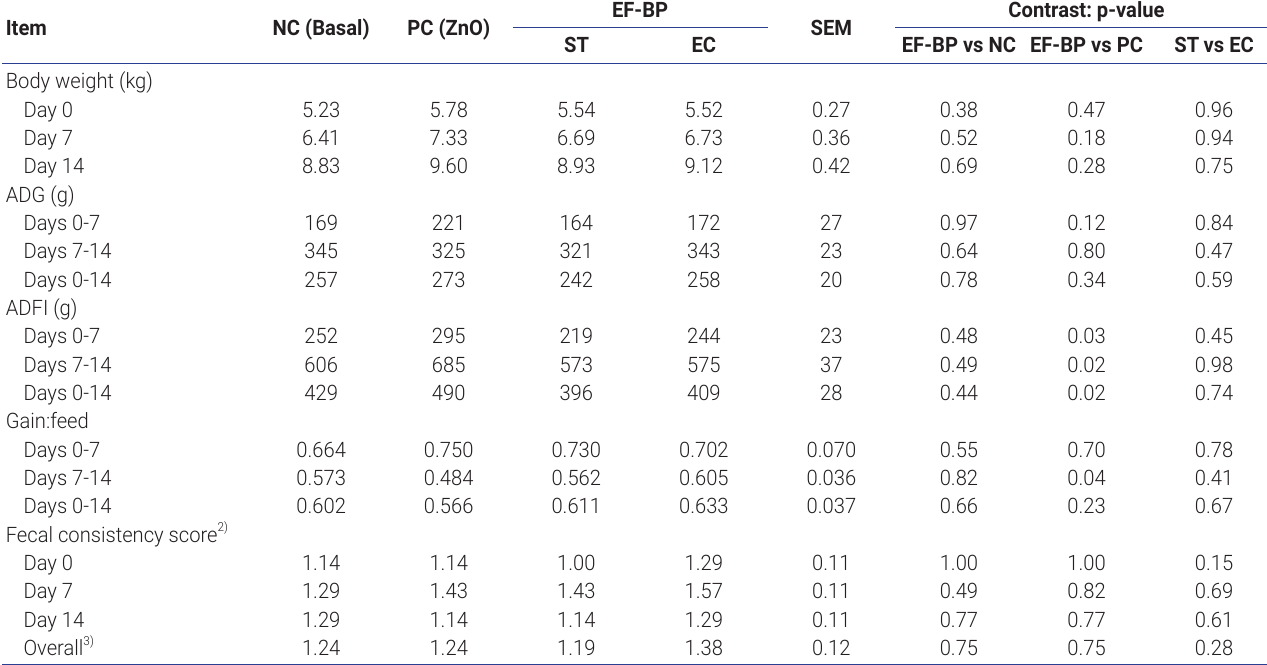
Table 3. Effects of direct-fed probiotic Enterococcus faecium plus bacteriophages on growth performance and fecal consistency score of individ- ually-fed weanling pigs (Experiment 1)